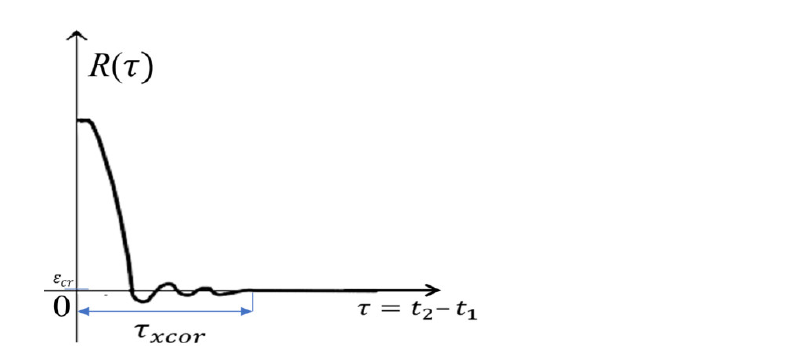
≈  is the time interval between the values   ) <  , where  is a small critical pa-    → 0).